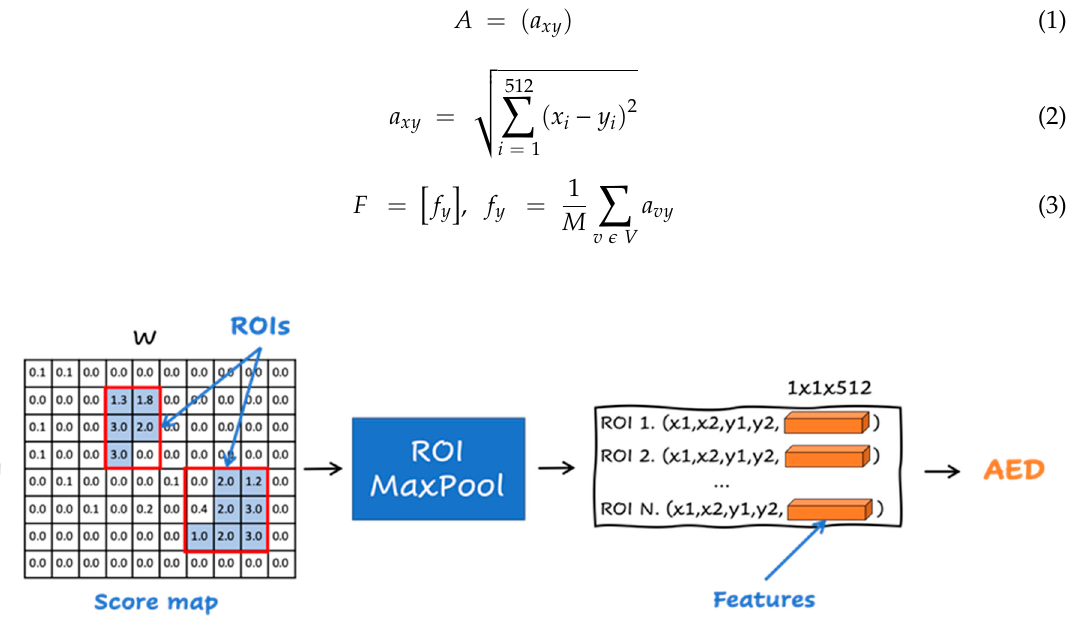
Figure 7. ScoreMap to ROI.